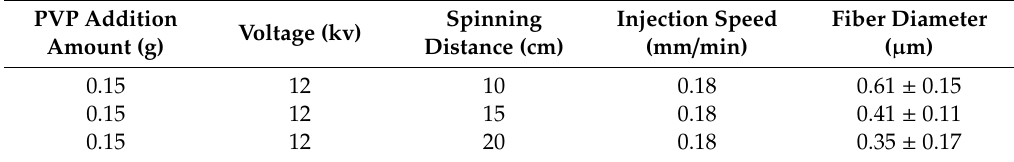
Table 4. The impact of the spinning distance on the diameter of fiber.